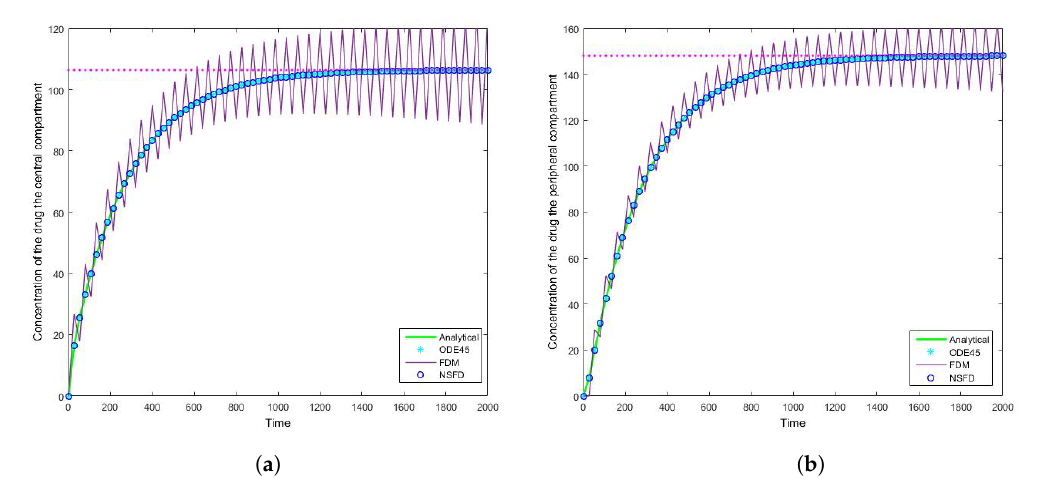
Figure 8. The concentration of the drug for Case 2 where h = 26.667 in the ( a ) central compartment, and ( b ) peripheral